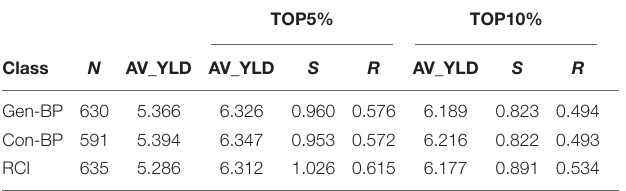
TABLE 5 | Experiment 1: Comparing the expected response to selection under 5 and 10% selection intensity for different selection schemes for average grain yield (AV_YLD ton/ha) derived from trials performed at the CENEB station in seasons 2013–2014 and 2014–2015.